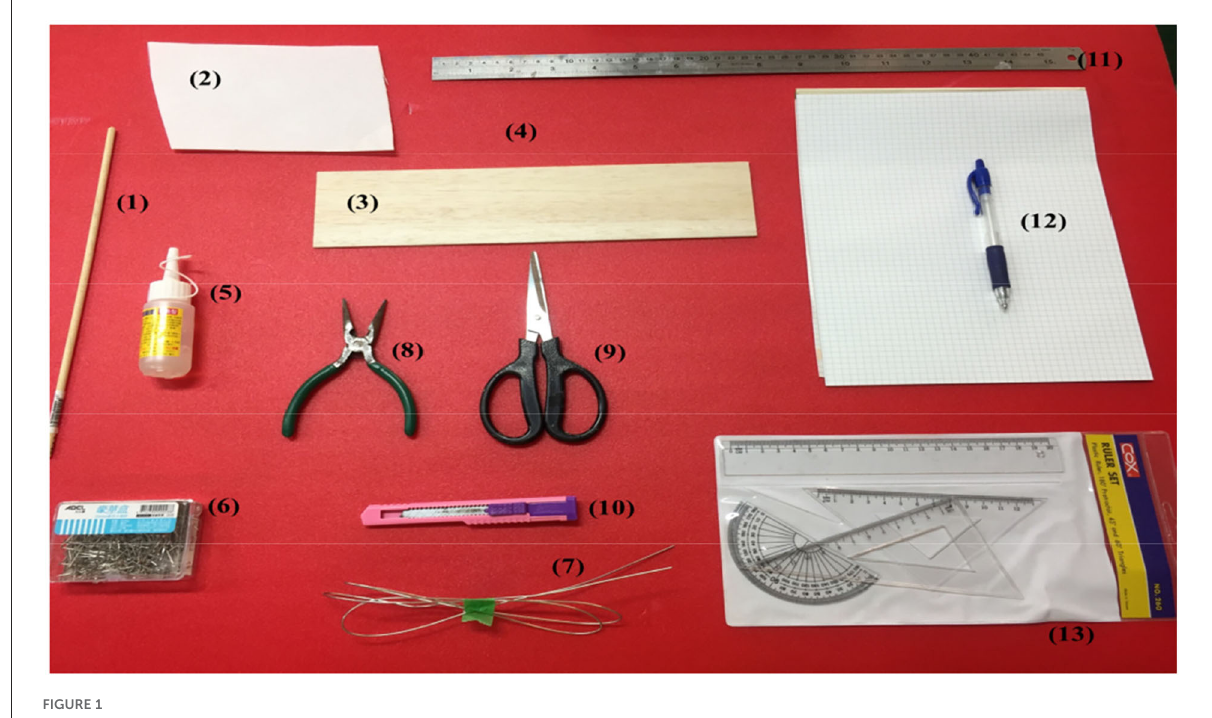
FIGURE1 Materials and tools for making the hull of a sailboat.